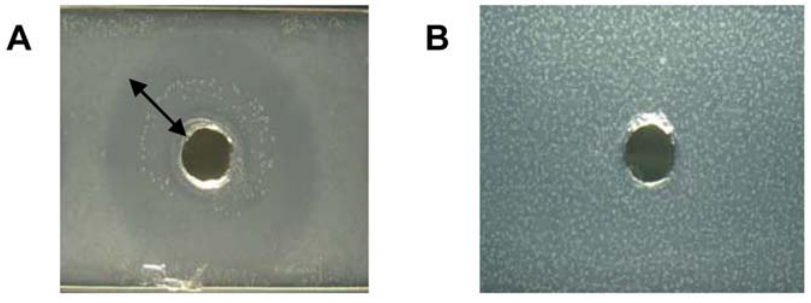
Figure 1. Stability of the compounds to Staphylococcusaureus (MN8) lipase. (A) Glycerol monolaurate (GML). (B) Dodecylglycerol (DDG). Clear zone indicates that the compound was degraded. Arrow denotes of the radius of the clear zone on the